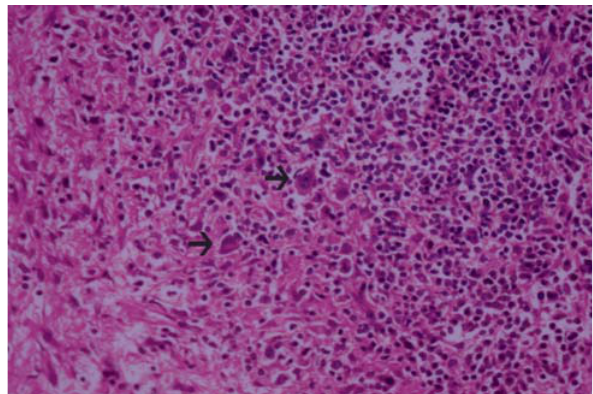
Fig 4. Photomicrograph of lymphocyte-predominant Hodgkin lymphoma showing CD45 +ve